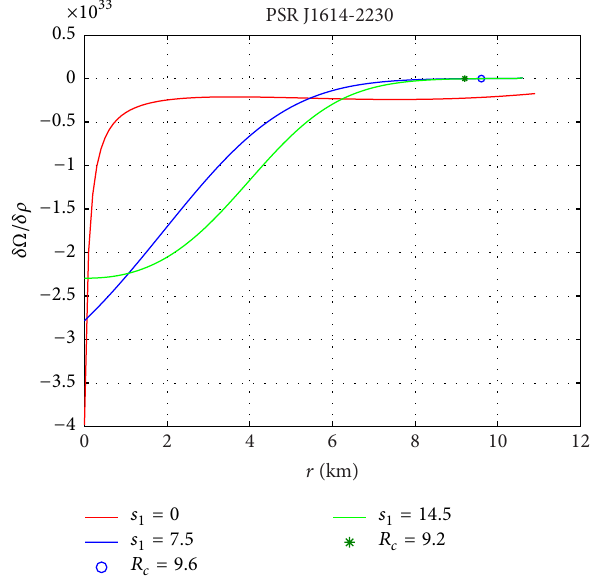
Figure 7: Stability regions for 𝛾 = 0.196 , 𝛼 = 0.06 , and 𝑠 1 = 0, 7.5, 14.5 .